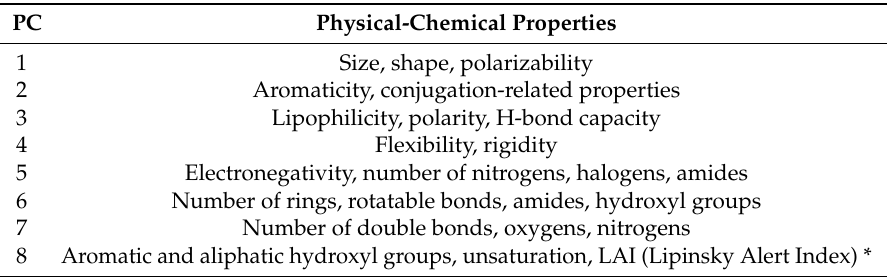
Table 6. Summary of the most important contributing characteristics of the eight dimensions in